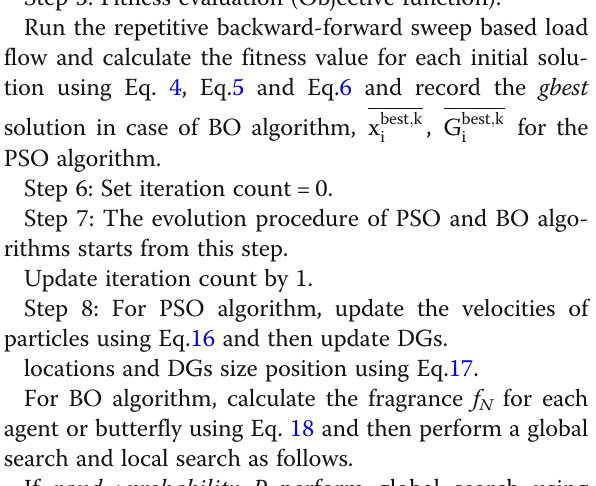
algorithm acceleration constants c1, c2 for BO